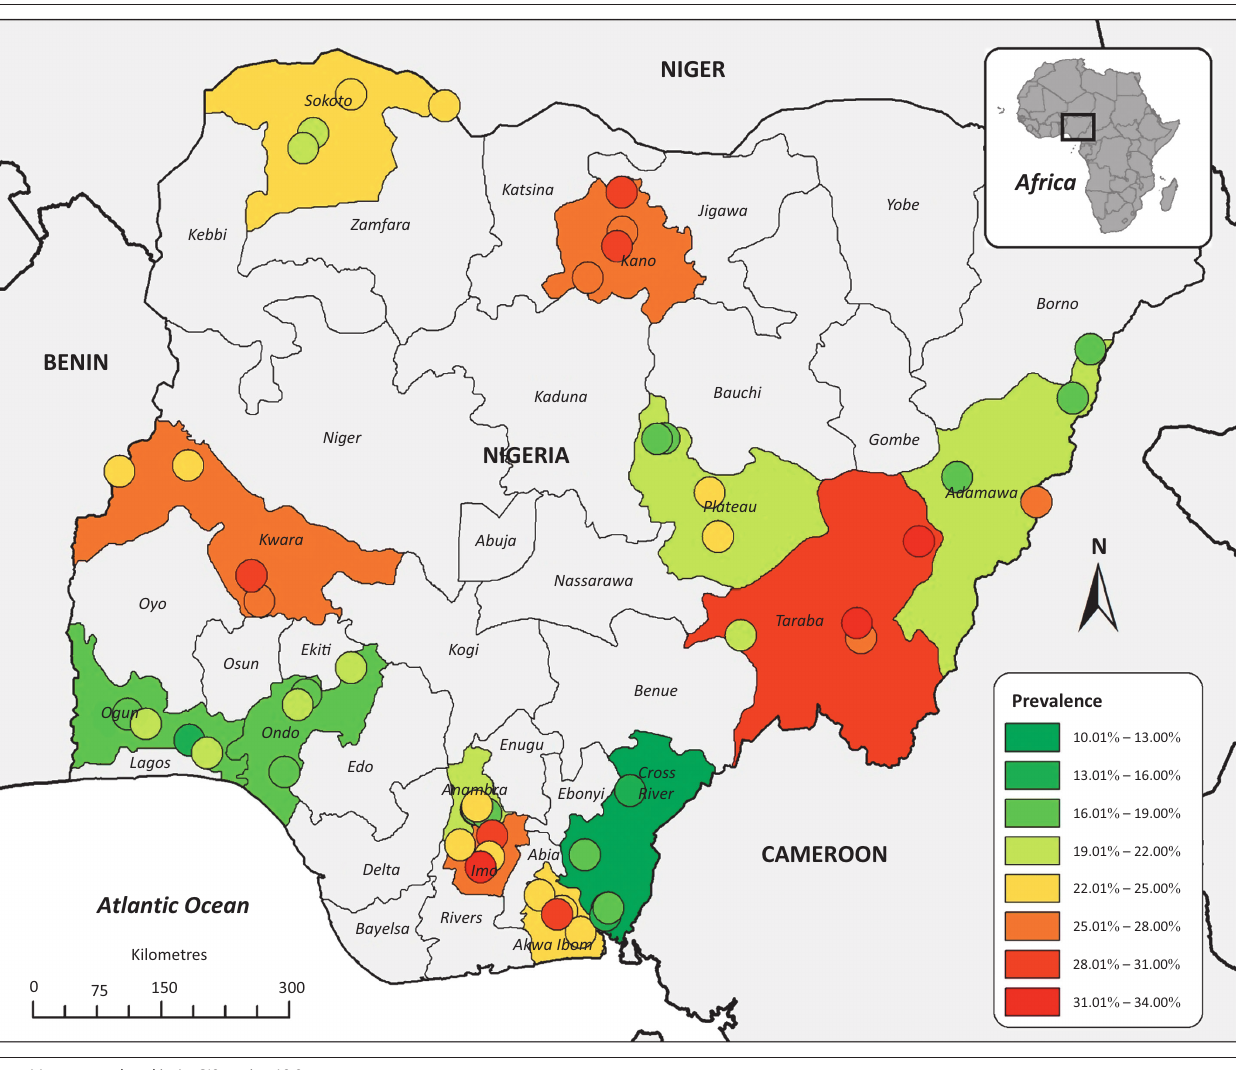
FIGURE 3: Prevalence of peste des petits ruminants virus antibodies in each locality indicated by coloured circles. The colour of each state indicates the overall prevalence in that